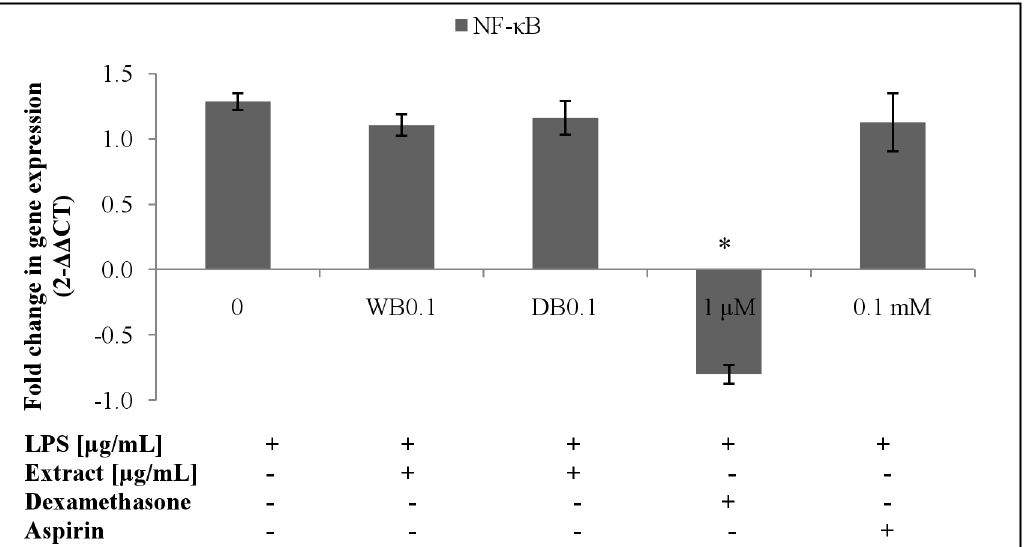
Fig 11. Effects of A . rugosum extracts on NF- κ B p65 gene expression (S1 Dataset). RAW264.7 cells were co-incubated with A . rugosum extracts (WB0.1: 0.1 μ g/mL WB; DB0.1: 0.1 μ g/mL DB) and 1 μ g/mL LPS for 24 hrs. Dexamethasone (1 μ M) and aspirin (0.1 mM) served as positive controls. β -actin was used as loading control and normalised against the treated group. Results shown represent the mean ± SD, n = 3 and * p < 0.05 versus LPS-induced NO level alone.